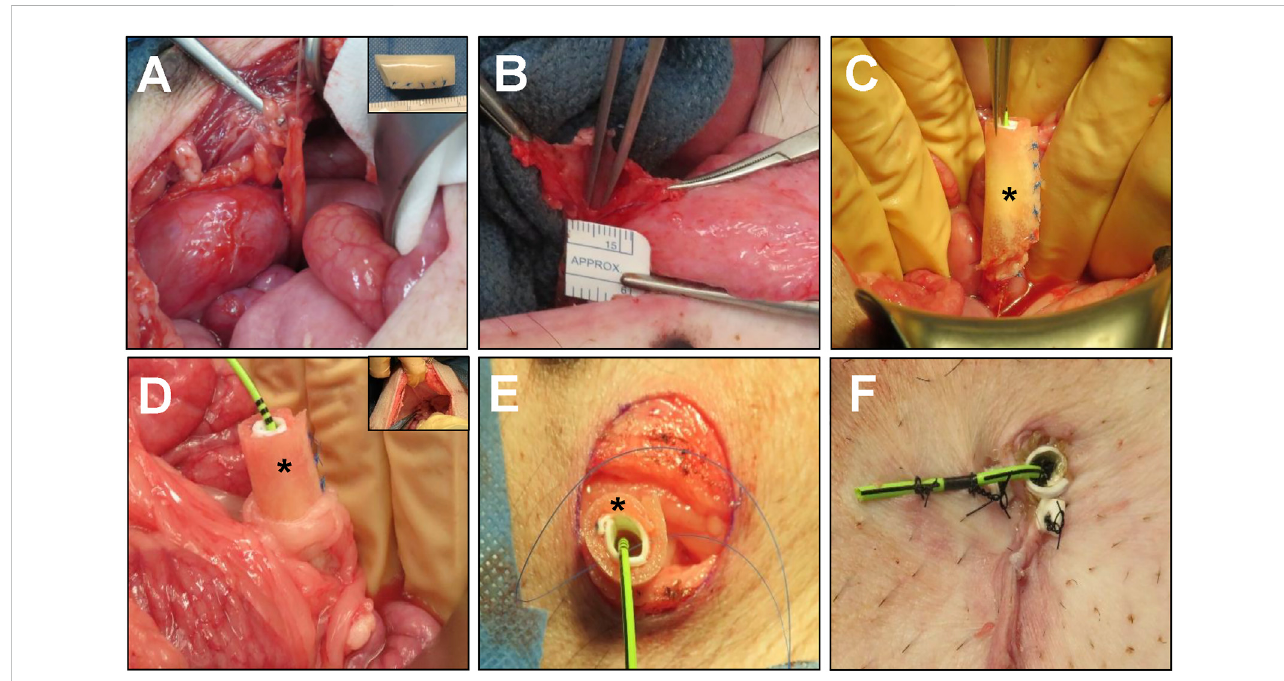
FIGURE 1 Porcineunilateralurinarydiversionmodel. (A) Isolationoftherightureterwithvascularsupplypreservation.Inset:BLSFtubularconduit. (B) Spatulationof the right ureter for construct implantation. (C) Oblique end-to-end anastomosis of BLSF conduit to the right ureter. (D) An omental fl ap was wrapped around the anastomosis and proximal half of the conduit to support de novo vascularization. Inset: Insertion of conduit through abdominal wall with omental wrap covering. The ureter-conduit anastomosis line was 3 – 5 mm away from the conduit insertion site at the abdominal wall. (E) Stomal creation and BLSF conduit placement at skin level. (F) Distal end of the BLSF construct with conduit and ureteral stent deployed and anchored to skin. (*) = BLSF tubular